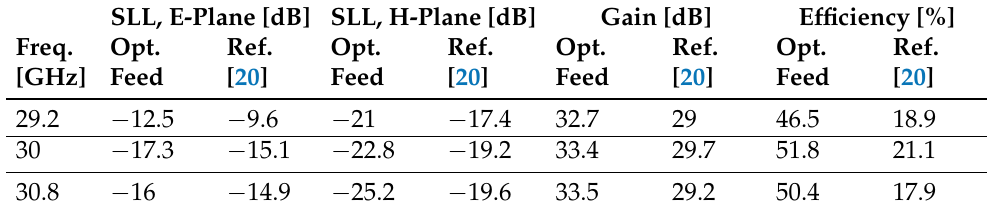
Table 1. Measured performance of the proposed CRA and comparison with the configuration in